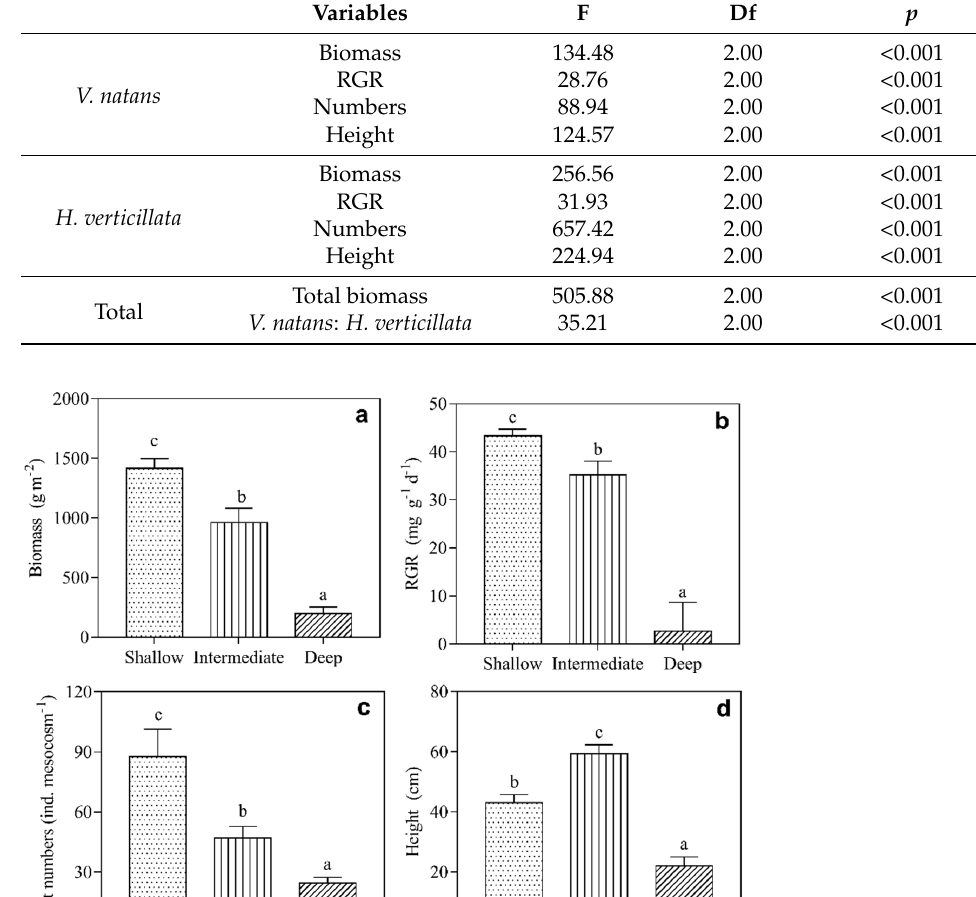
Table 1. Changes in light (light intensity of target depth to water surface), total nitrogen (TN), total phosphorus (TP), total dissolved nitrogen (TDN), total dissolved phosphorus (TDP), and chlorophyll a (Chl- a ) concentrations during the experi- ment.